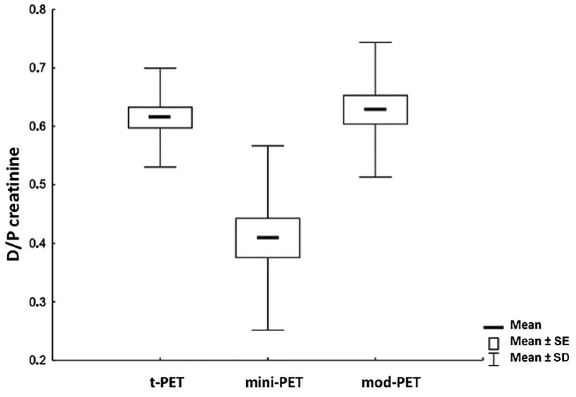
Figure 1. Dialysate-to-plasma concentration ratio (D/P) for creatinine in traditional peritoneal equilibration test (t-PET) vs mini-PET vs modi fi ed (mod)-PET (n=20). According to the repeated measures ANOVA, D/P creatinine did not differ between t-PET and mod-PET (P=0.746), but there was a signi fi cant difference between t-PET and mini-PET (P o 0.001) and between mod-PET and mini-PET (P 4